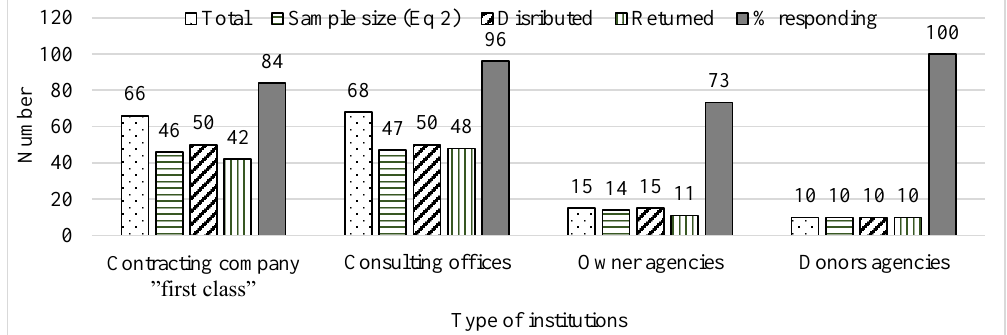
Figure 4. Statistics regarding the research’s target groups.